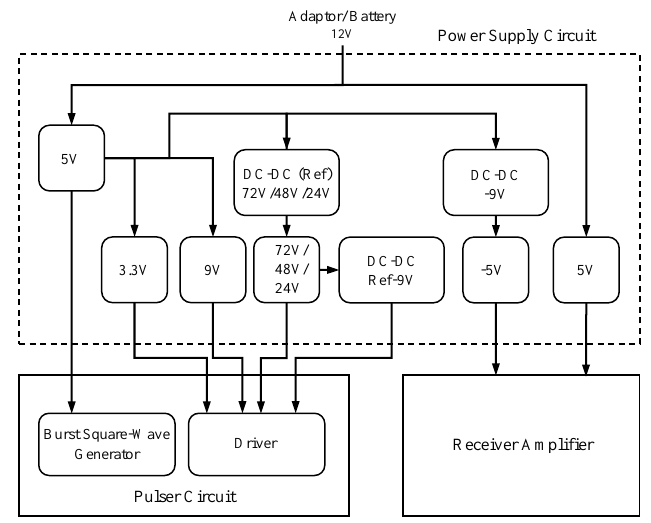
Figure 9. Block diagram of the power supply circuit.